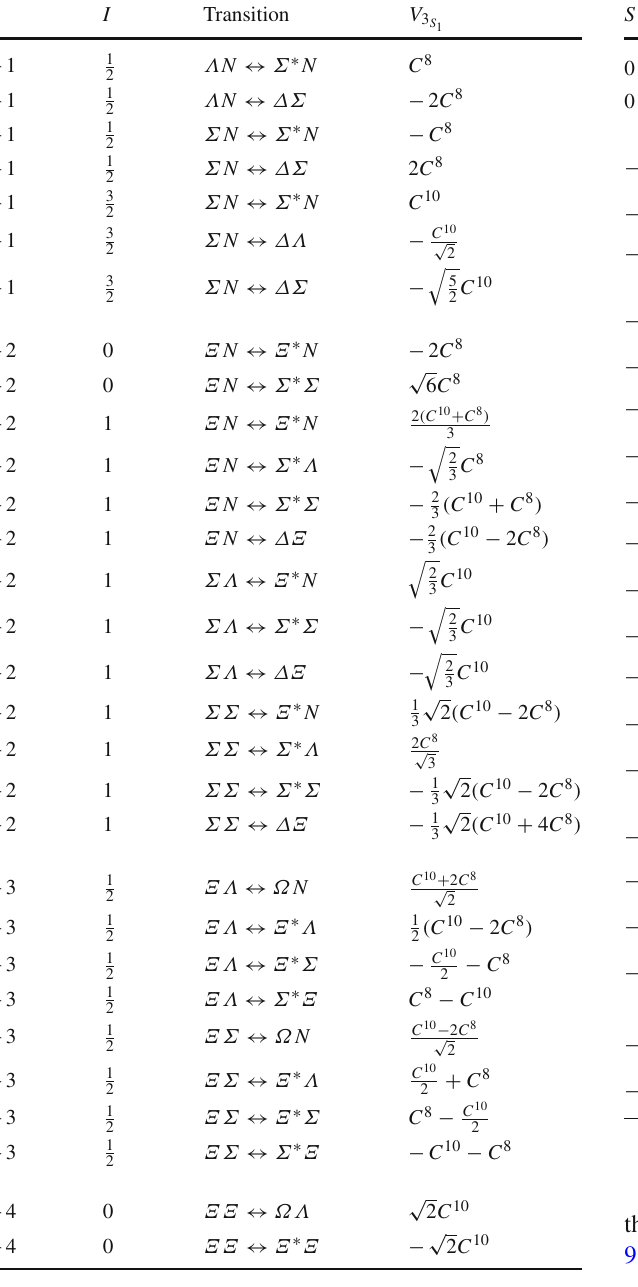
Table 7 SU(3) relations of BB → DB (and DB → BB) in non- vanishing partial waves. The subscript { 01 } of the constants C r denotes the BB channel is omitted in the table